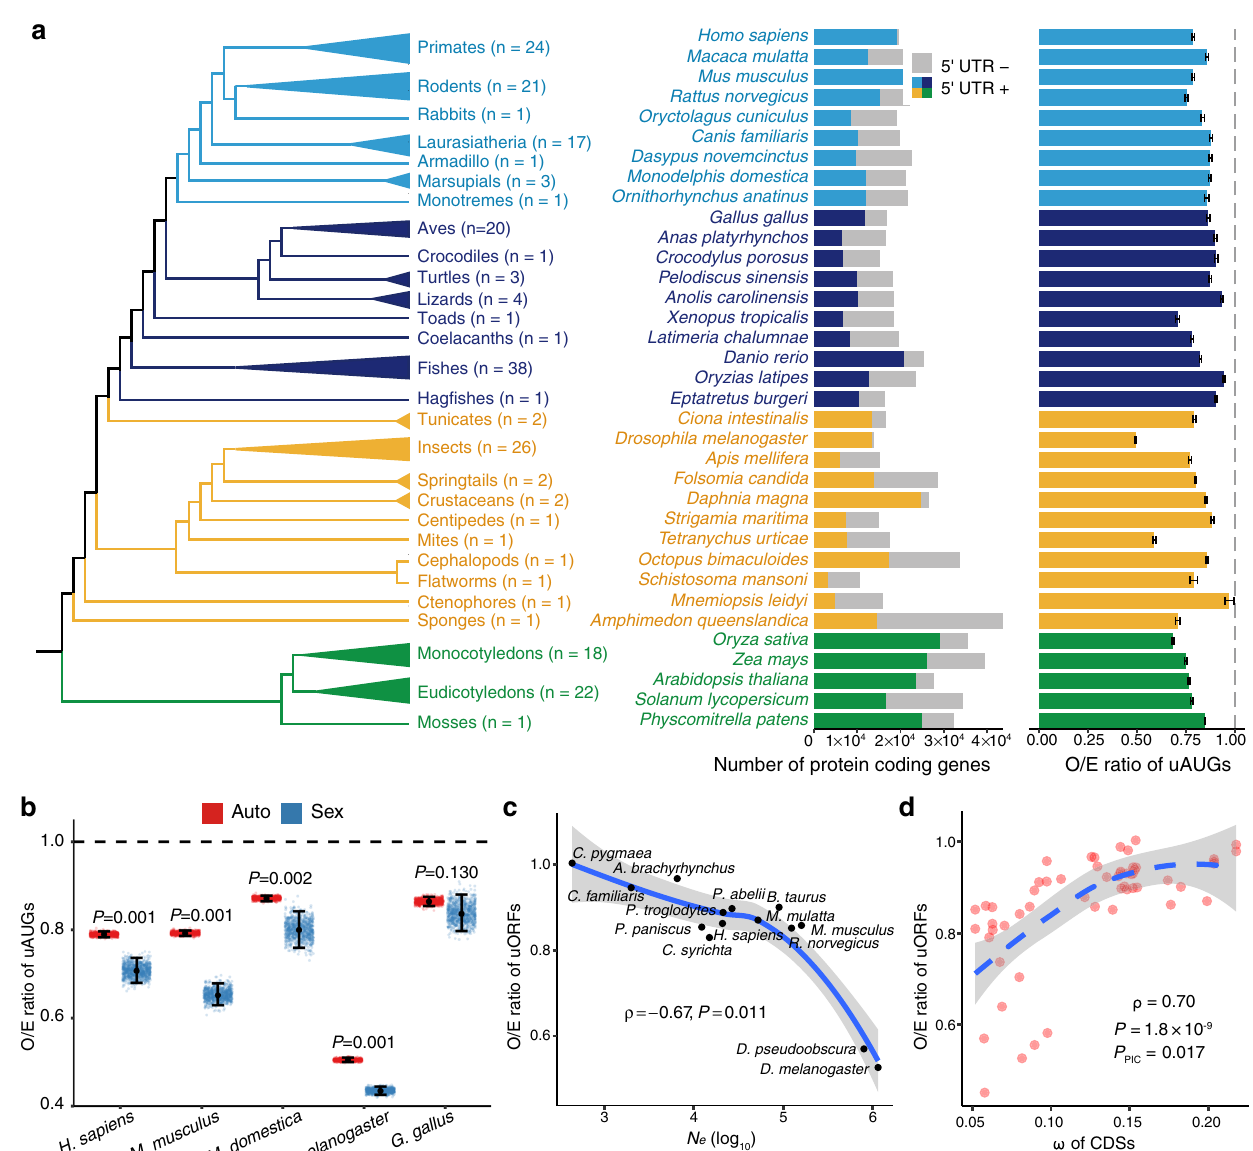
Fig. 1 Variability of upstream AUG (uAUG) prevalence among eukaryotes and evolutionary driving forces. a Overview of the 216 eukaryotes analyzed in this study. The left panel is the cladogram of the 216 eukaryotes. The number of species in each clade is shown in brackets. The middle panel shows the total number of protein-coding genes in 35 representative species. Genes with an annotated 5 ′ untranslated regions (5 ′ UTR + ) are colored by clade, and those without 5 ′ UTR annotation (5 ′ UTR-) are shown in gray. The unavailability of annotated 5 ′ UTRs for many genes in less-studied organisms is presumably caused by the lack of accurate annotations. The right panel shows the ratio of the observed number of uAUGs to the expected number of uAUGs (O/E ratio) in the 35 species. The error bars indicate the 95% con fi dence interval of the O/E ratio. b O/E ratios of uAUGs in sex chromosome (X or Z) genes (Sex, blue) and autosomal genes (Auto, red) in humans, mice, opossum, fl ies, and chickens. n = 1000 permutation replicates for each category of genes in each species. Center point, median; error bars, 95% con fi dence intervals. P values were obtained by two-sided Wilcoxon signed-rank tests, and no correction for multiple testing was made. c Relationship between the effective population size ( N e ) and the O/E ratio of uORFs among 14 animals. The blue line indicates the local polynomial regression fi t of the O/E ratio against N e , and the gray band indicates the standard error of the fi t. Spearman ’ s correlation ( ρ ) between N e and the O/E ratio and the two-sided P value are shown in the plot. d Relationship between the genome-wide median number of nonsynonymous changes per nonsynonymous site over the number of synonymous changes per synonymous site ( ω ) of coding sequences (CDSs) and the O/E ratio of uORFs among 56 animals. The blue line indicates the local polynomial regression fi t and the gray band indicates the standard error of the fi t. Both Spearman ’ s correlation and the signi fi cance of the two-sided phylogenetic independent contrast (PIC) between ω and the O/E ratio ( P PIC ) are shown. Source data are provided as a Source Data fi